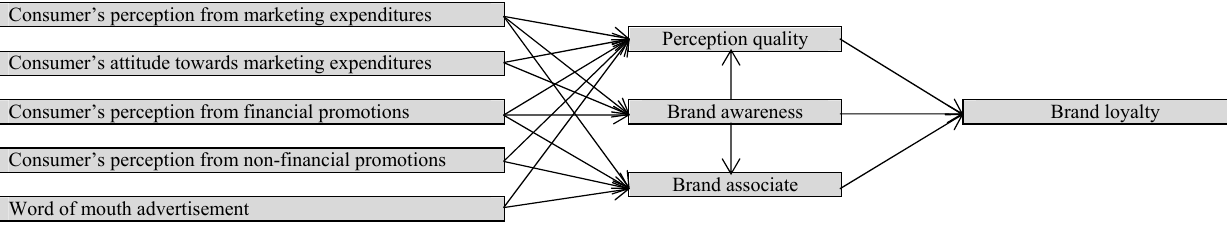
Fig. 1. The proposed study (Ref: Buil et al.,